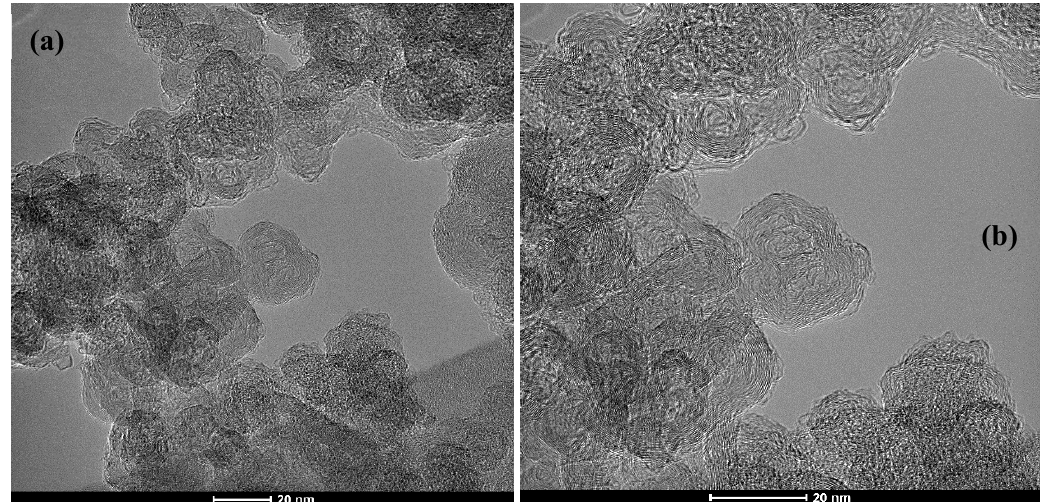
Figure 5. TEM images of microwave plasma processed XC-72 at ( a ) low and ( b ) high magnification.